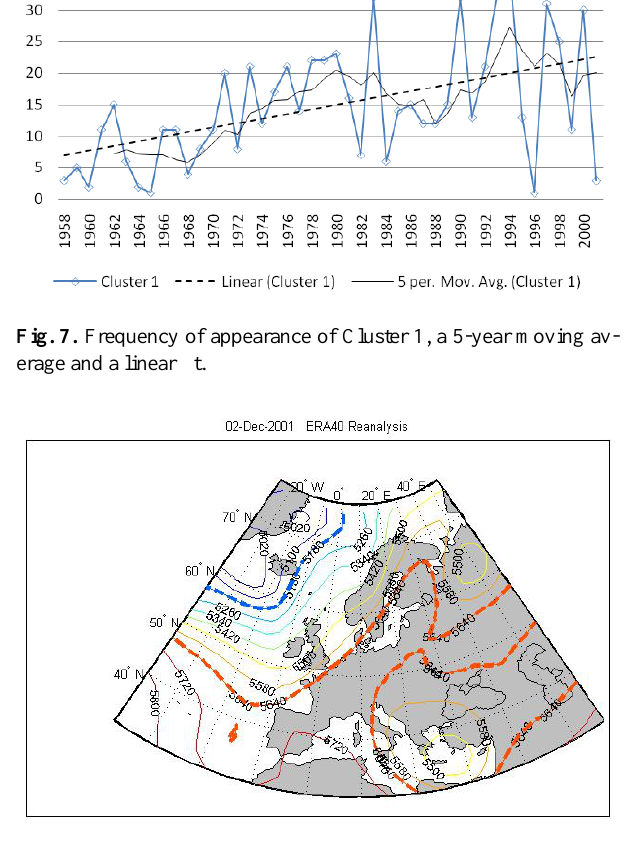
Fig. 8. Typical pattern of Cluster 9: 2 December 2001 (units: gpm).